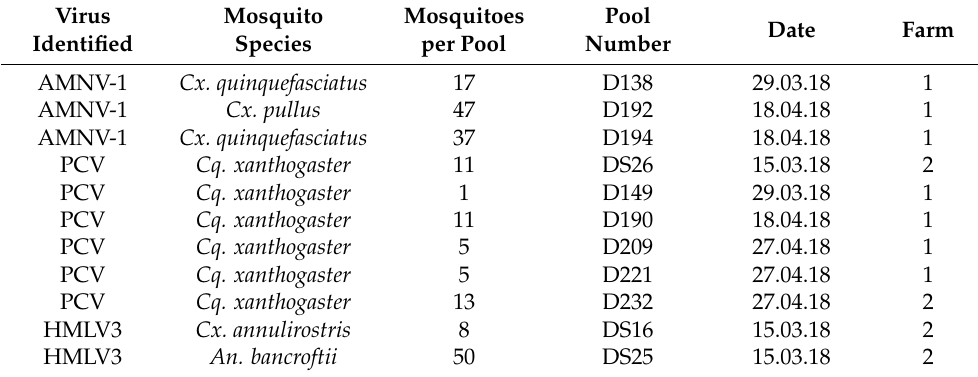
Table 2. List of MAVRIC-positive samples with identified viruses out of the 198 mosquito